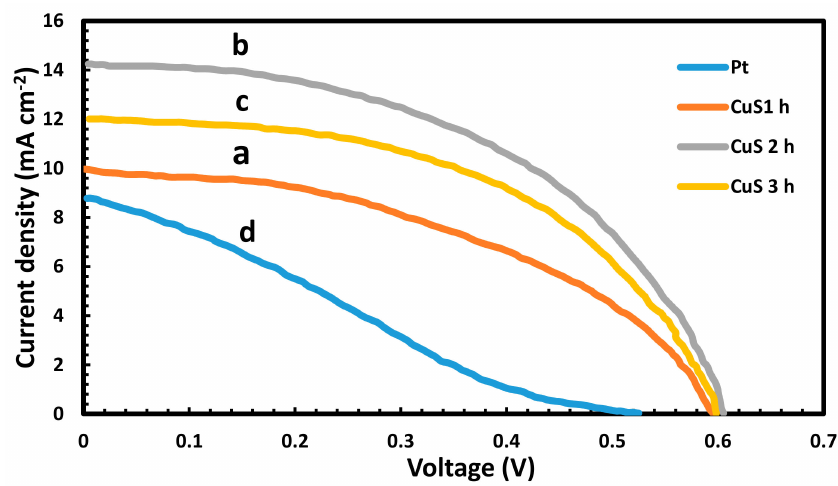
Figure 9. (J–V) of TiO2 / CdS / CdSe / ZnS QDSSCs with CuS and Pt CEs (reproduced from ref. [130]